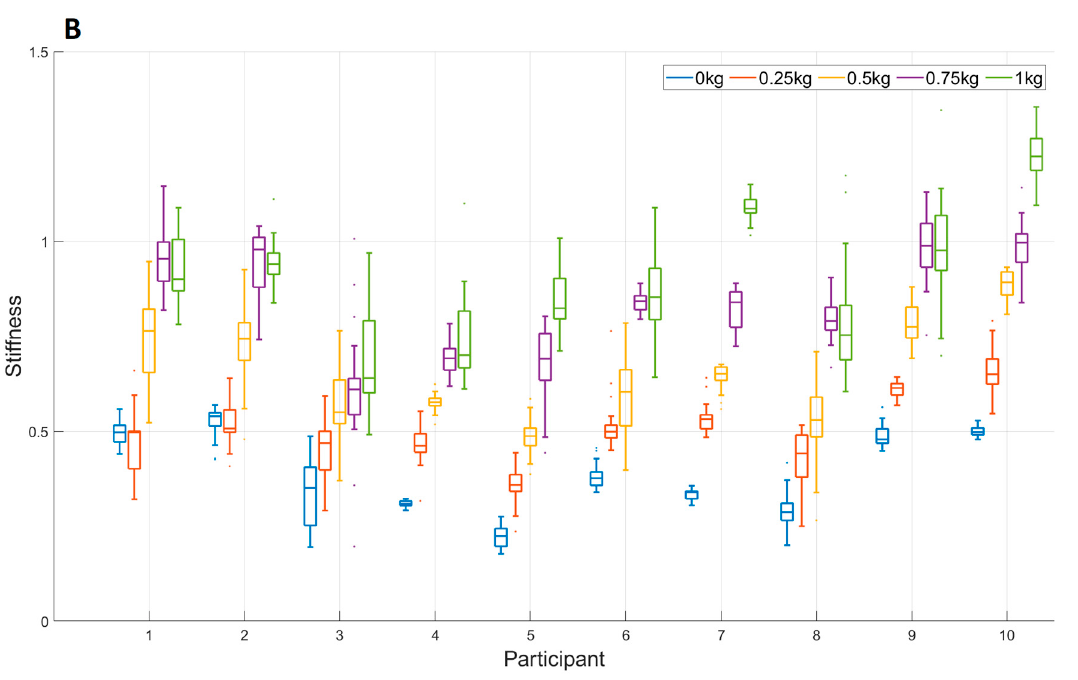
Figure 8. Comparative analysis of ( A ) elbow joint stiffness mean value for participant 9; ( B ) stiffness value for each tempo for all 10 participants in task E2.